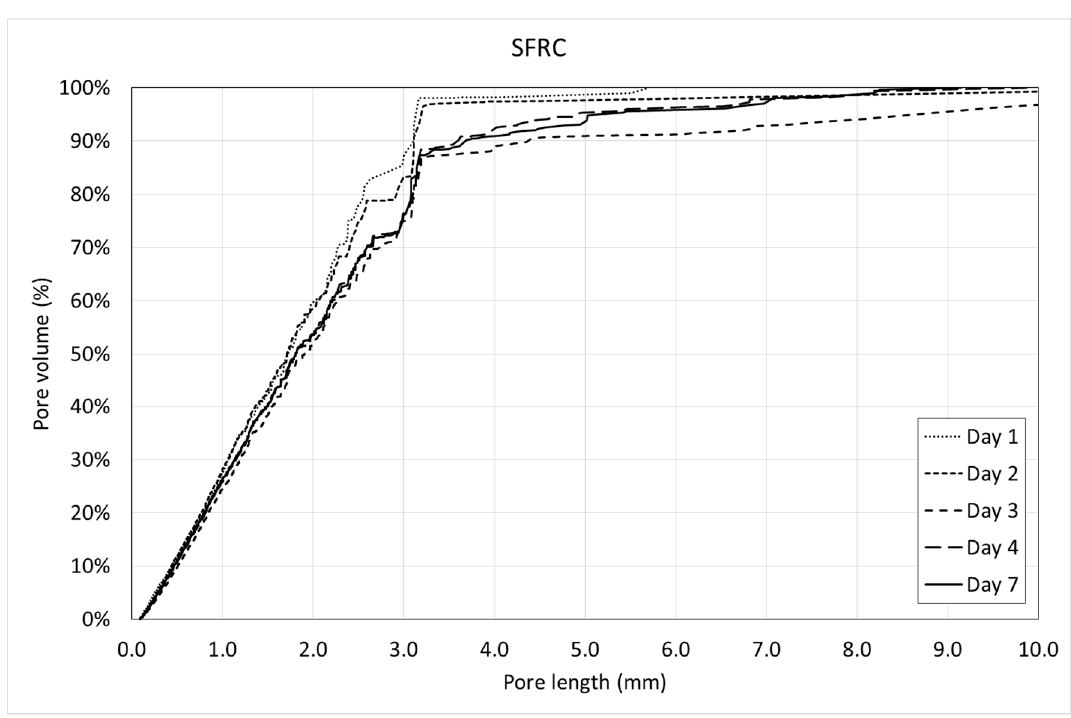
Figure 15. Porosimetric curves of SFRC.